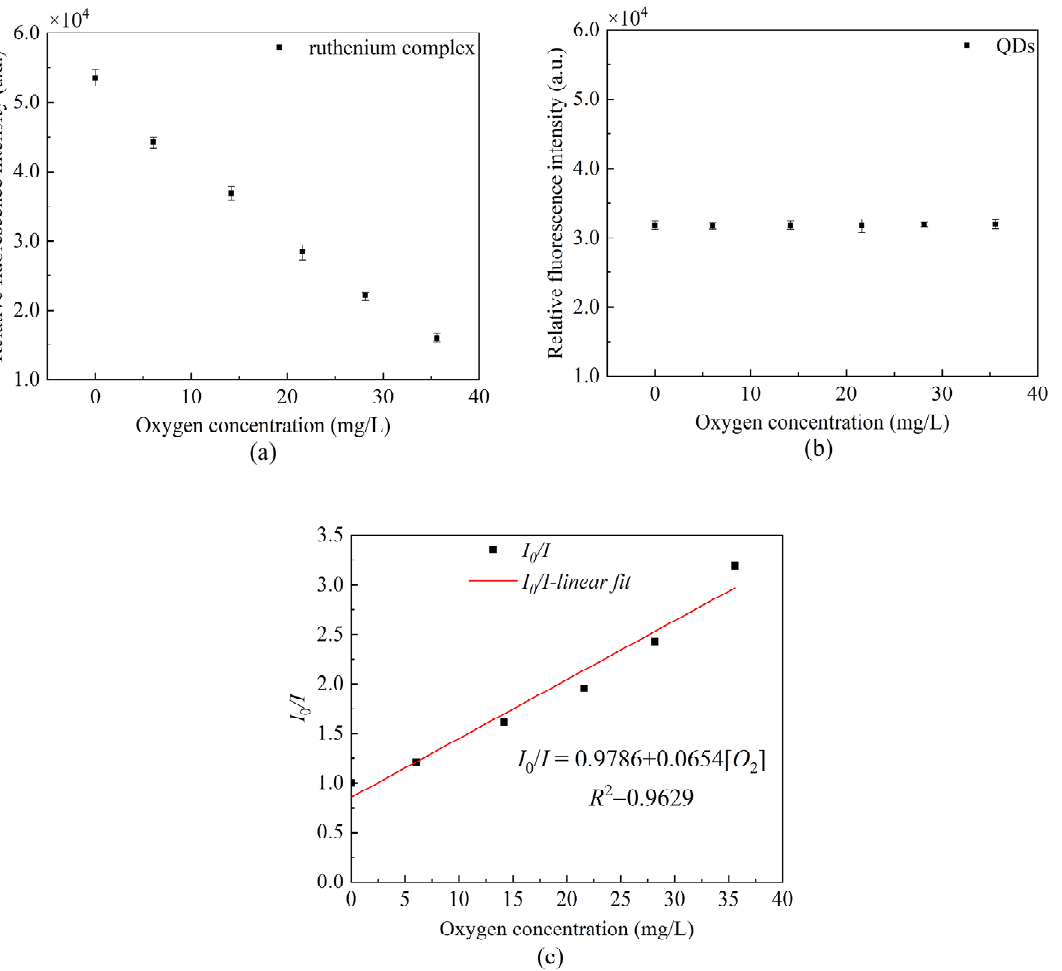
Figure 7. Fluorescence intensity at different oxygen concentrations ( a ) peak fluorescence intensity of ruthenium complex, ( b ) peak fluorescence intensity of QDs, and ( c ) Stern–Volmer equation curve in the presence of ruthenium complex alone.